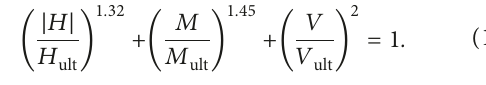
Figure 15: Moment under various loading eccentricities. (a) Moment versus the rotation angle. (b) Maximum moment versus load